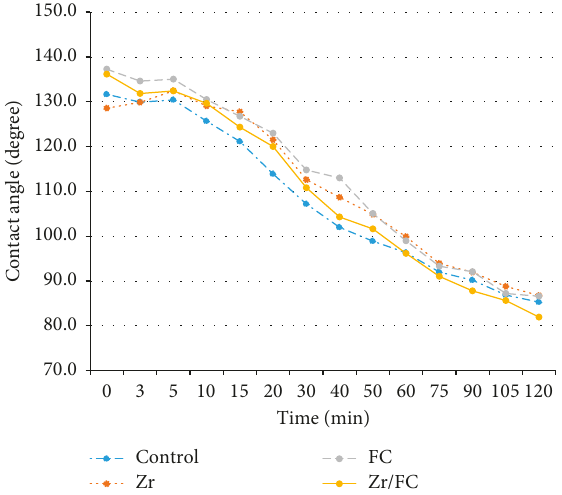
Figure 5: Correlation between the contact angle values and time in the four experimental groups. Control: specimens with no surface treatment, Zr: plasma exposure on zirconia, FC: plasma exposure on feldspathic ceramic, Zr/FC: plasma exposure on both zirconia and feldspathic ceramic.